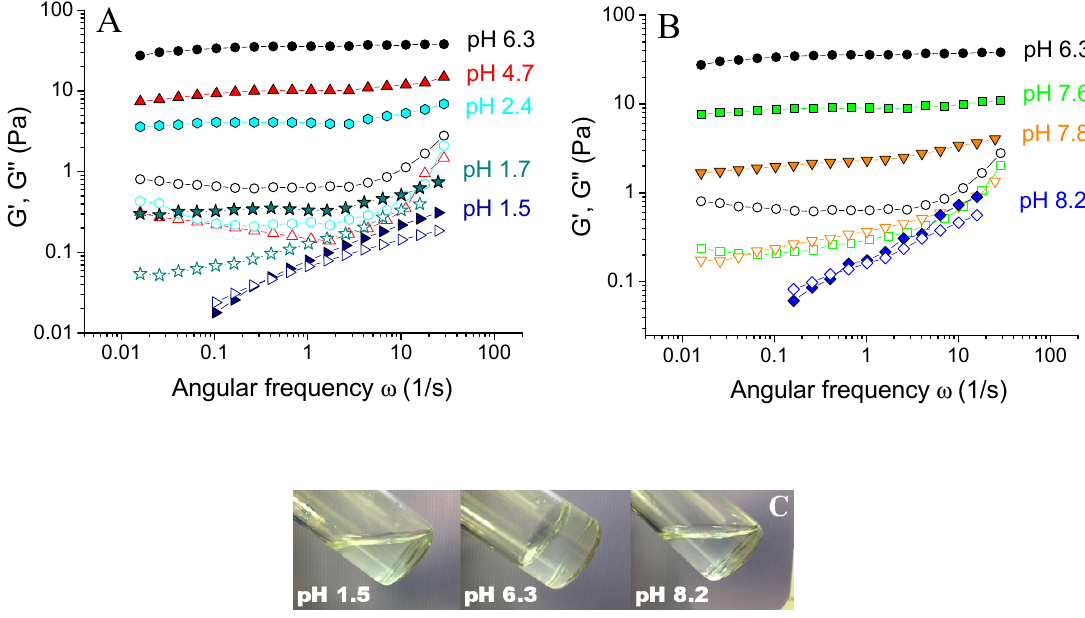
Figure 2. Frequency dependences of storage G ʹ ( fi lled symbols) and loss G” (open symbols) moduli for 0.1 wt % xanthan aqueous solutions in the presence of 0.017 wt % CrCl 3 (molar ratio [CrCl 3 ]/[xanthan monomer units] = 1) prepared at different pH: 1.5 (tilted triangles), 1.7 (stars), 2.4 (diamonds), 4.7 (triangles), 6.3 (circles), 7.6 (squares), 7.8 (reverse triangles) and 8.2 (diamonds), at 20 °C ( A and B ). Photographs of 0.1 wt % xanthan aqueous solutions in the presence of 0.017 wt % CrCl 3 prepared at different pH ( C ).